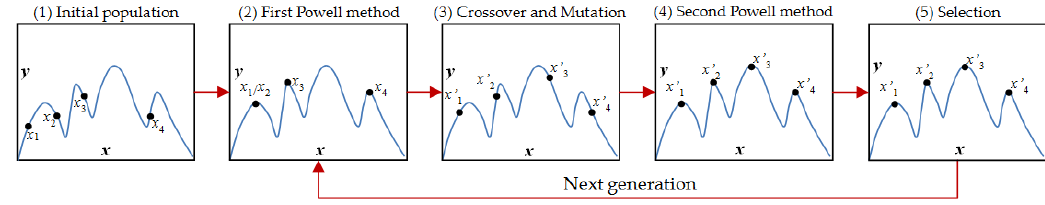
Figure 2. The process illustration of the HGAP to locate the maximum value point.